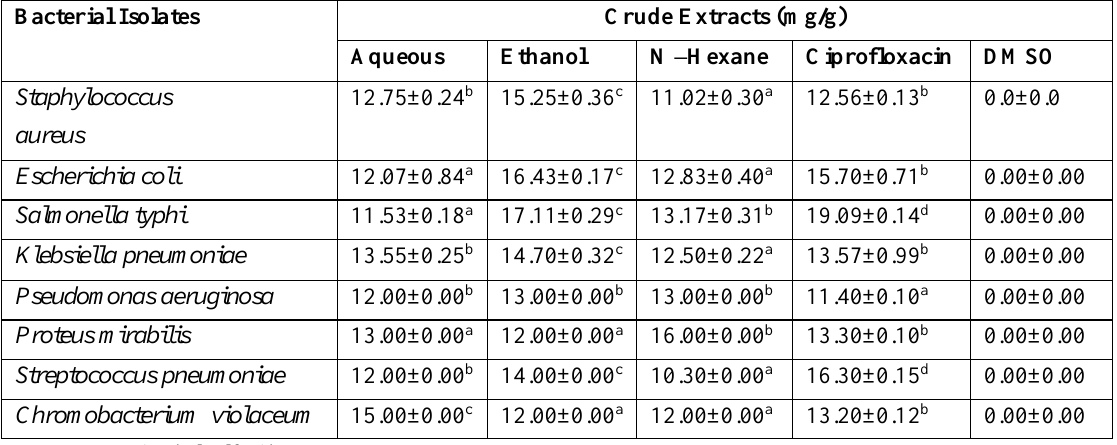
Table 4. Antibacterial activity of crude leaf extracts of Citrus aurantium (100mg/ml) on bacteria isolated from HBV patients.